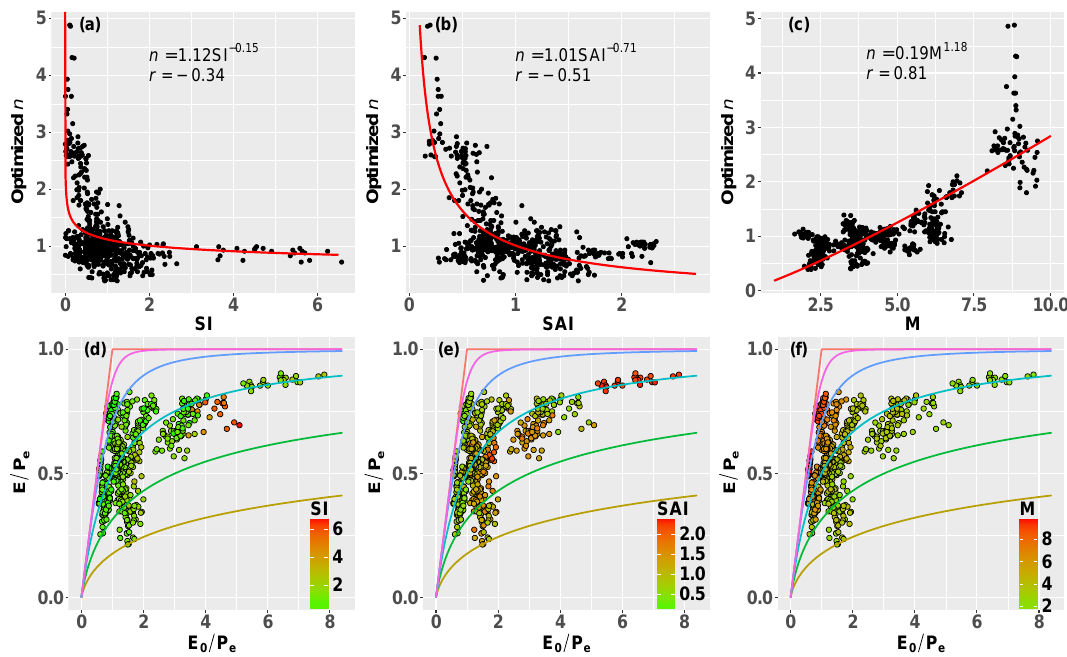
Figure 4. Relationship between optimized n and (a) SI, (b) SAI and (c) M . (d–f) Distribution of evapotranspiration ratio ( E /P e ) as a function of the aridity index ( E 0 /P e ), classified by 26 global large river basins at annual scale. The Budyko curves from the top down are derived from Eq. (2b) with n = ∞ , n = 5, n = 2, n = 1, n = 0 . 6 and n = 0 . 4, respectively. Note that each point represents 1 year based on the combined dataset from 26 global large